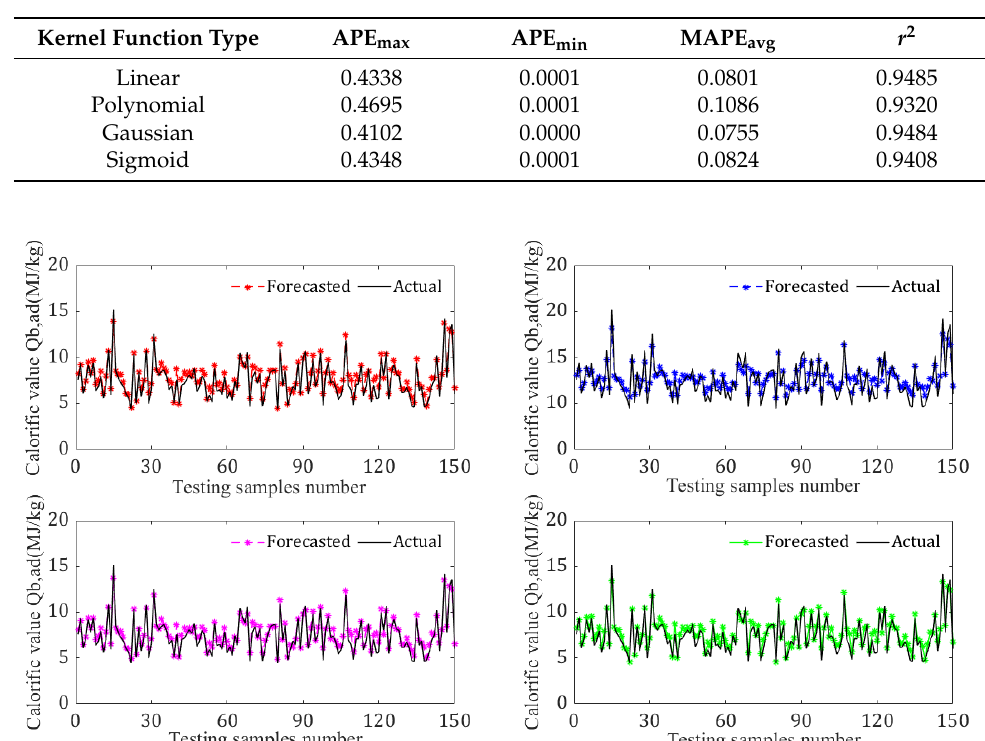
Figure 8. Comparison of forecasted calorific value ( Q b,ad ) on different single kernel functions.